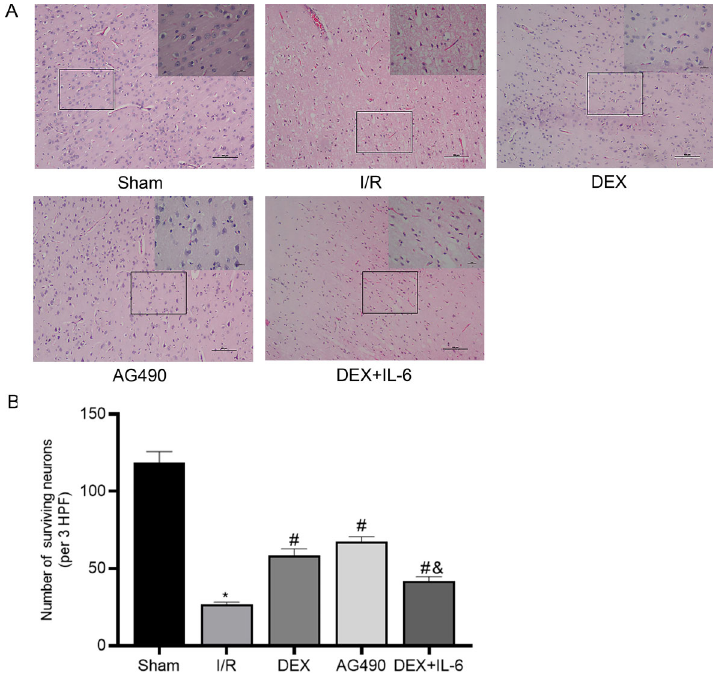
Figure 4. A , HE staining ( (cid:3) 100 and 400, scale bars 100 and 20 m m) of rat brain tissue. B , Number of surviving neurons (per 3 HPF). Data are reported as means ± SD, n=5. *P o 0.05 vs Sham group; # P o 0.05 vs I/R group; & P o 0.05 vs DEX group (one-way ANOVA). I/R: ischemia/reperfusion; DEX: dexmedetomidine; IL-6: interleukin-6; HPF: high-power fi elds.